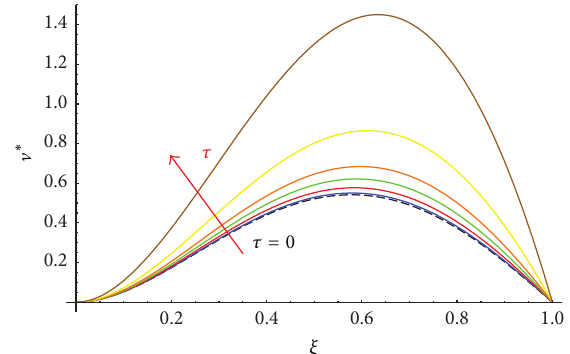
Figure 2: Dimensionless transverse displacement V ∗ for the clamped-simply supported nanobeam versus 𝜉 for 𝜏 ∈ {0, 0.05, 0.1, 0.15, 0.2, 0.3, 0.5}